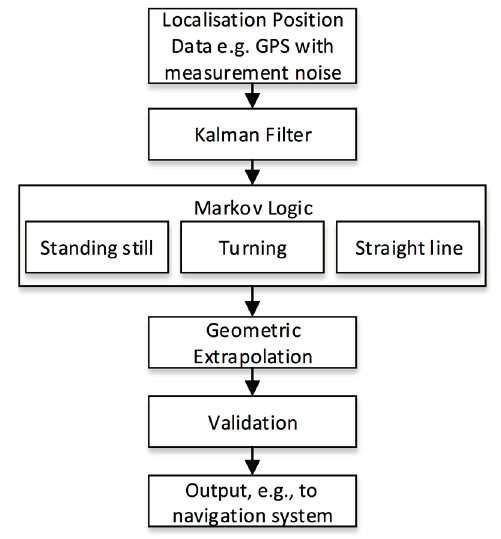
Figure 1. Block algorithm of the prediction